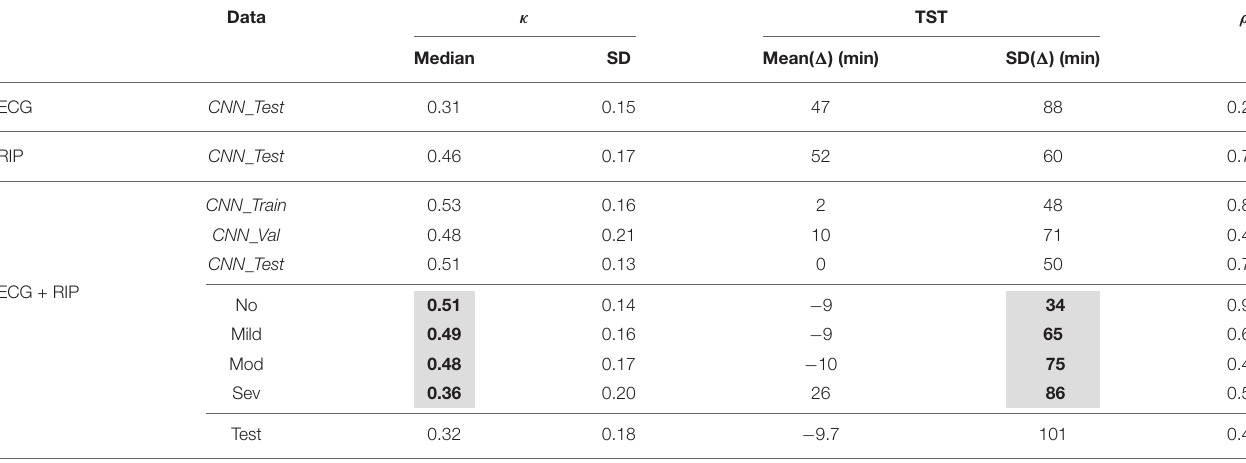
TABLE 2 | Sleep-wake classification of the unimodal and multimodal networks and TST estimates.